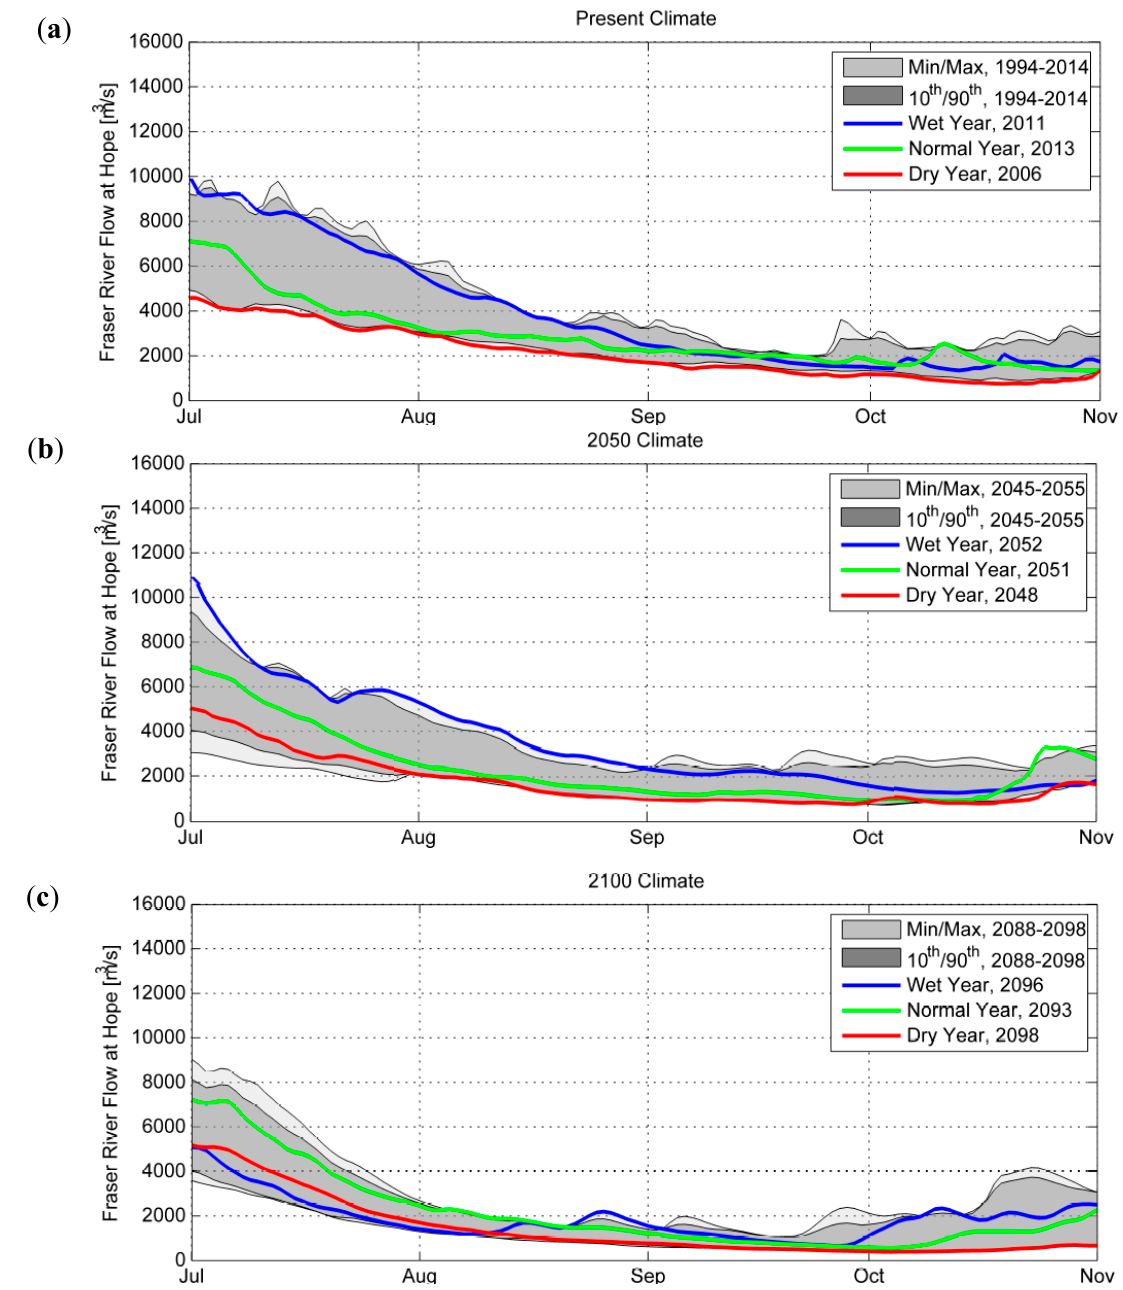
Figure 10. Statistical comparison of selected hydrographs for various timeframes: ( a ) present timeframe; ( b ) year 2050 timeframe; ( c ) year 2100 timeframe.